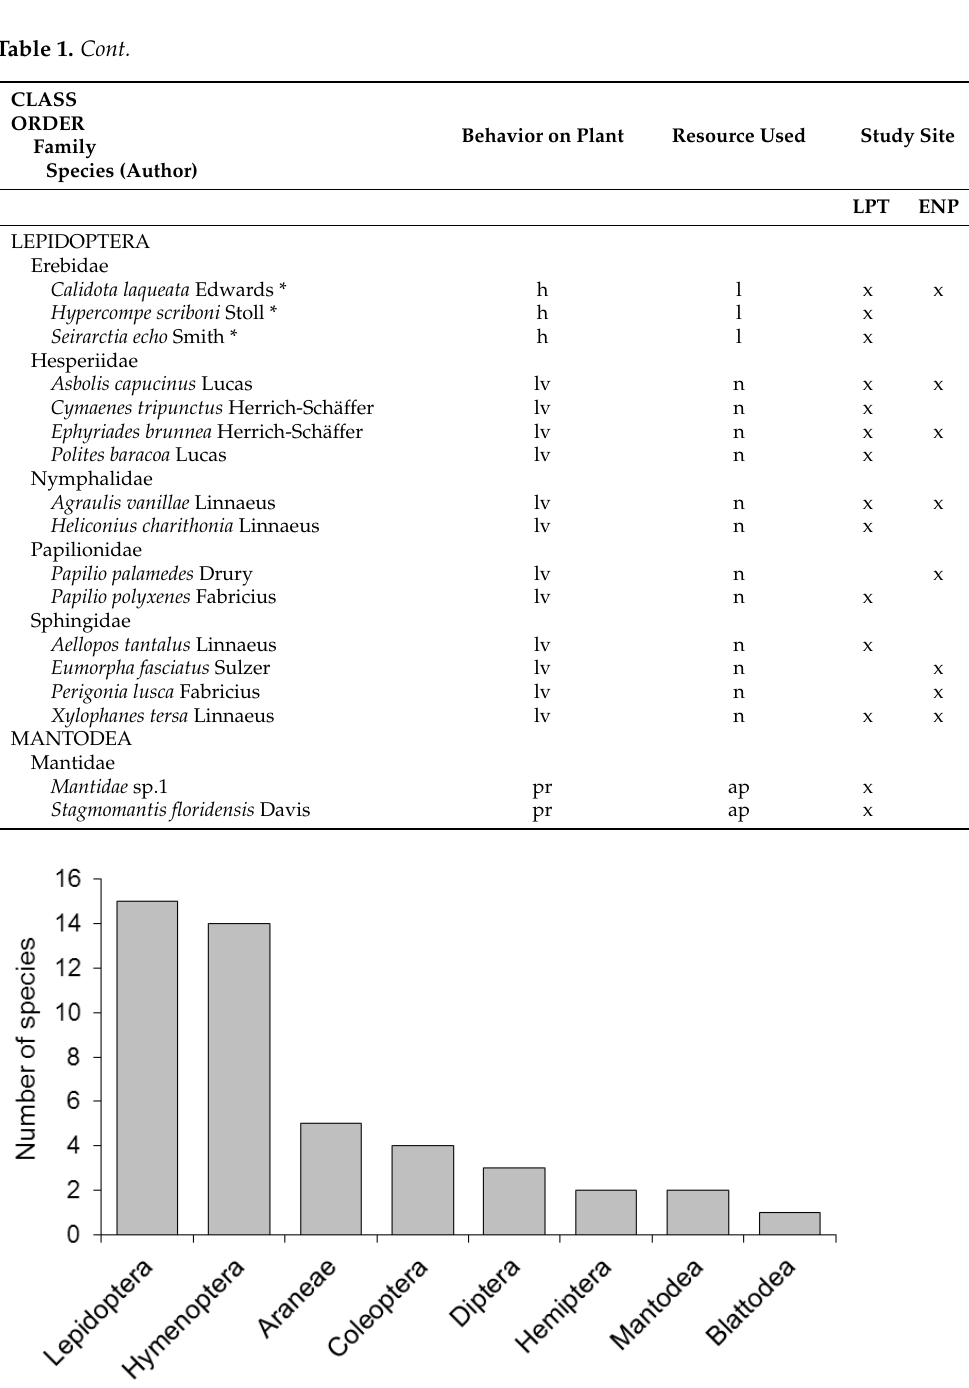
Figure 2. Arthropod orders observed on flowers of Guettarda scabra , sorted according to the number of species found. The large numbers of lepidopterans and hymenopterans are mostly related to diurnal activity in these two groups. Table 1. Array of arthropods associated with Guettarda scabra , their behaviors, and plant resources used at two pine rockland sites (Larry and Penny Thompson Memorial Park: LPT; and Long Pine Key, Everglades National Park: ENP) in south Florida. Observed behaviors abbreviated as follows: predation on other arthropods (pr), legitimate visitation (lv), primary nectar robbing (1nr), second- ary nectar robbing (2nr), and herbivory (h). Plant resources used by visitor abbreviated as follows: arthropod prey (ap), nectar (n), pollen (p), floral tissue (f), and leaves (l). Asterisks signify caterpillar